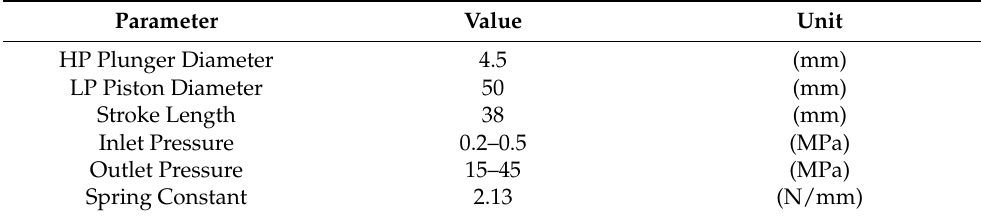
Table 1. Parameters for the preliminary design of the needle-free jet